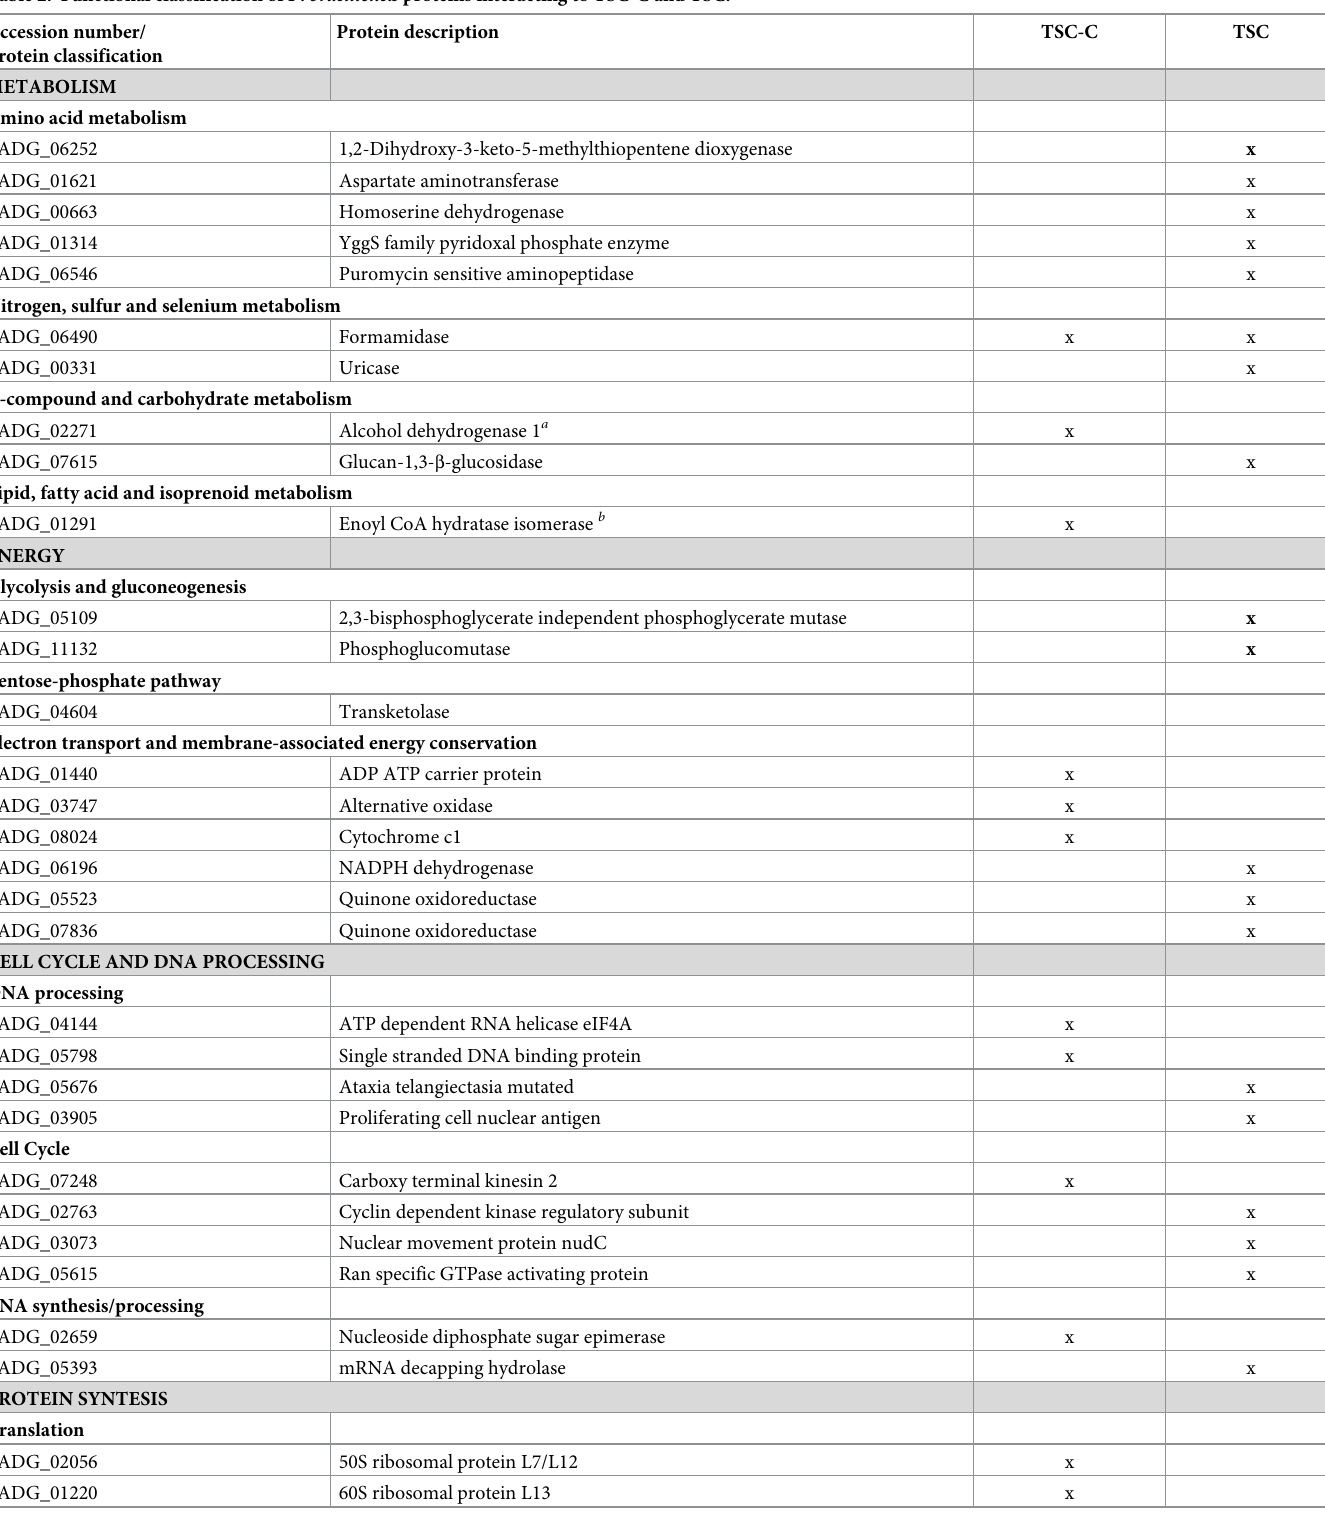
Table 2. Functional classification of P . brasiliensis proteins interacting to TSC-C and